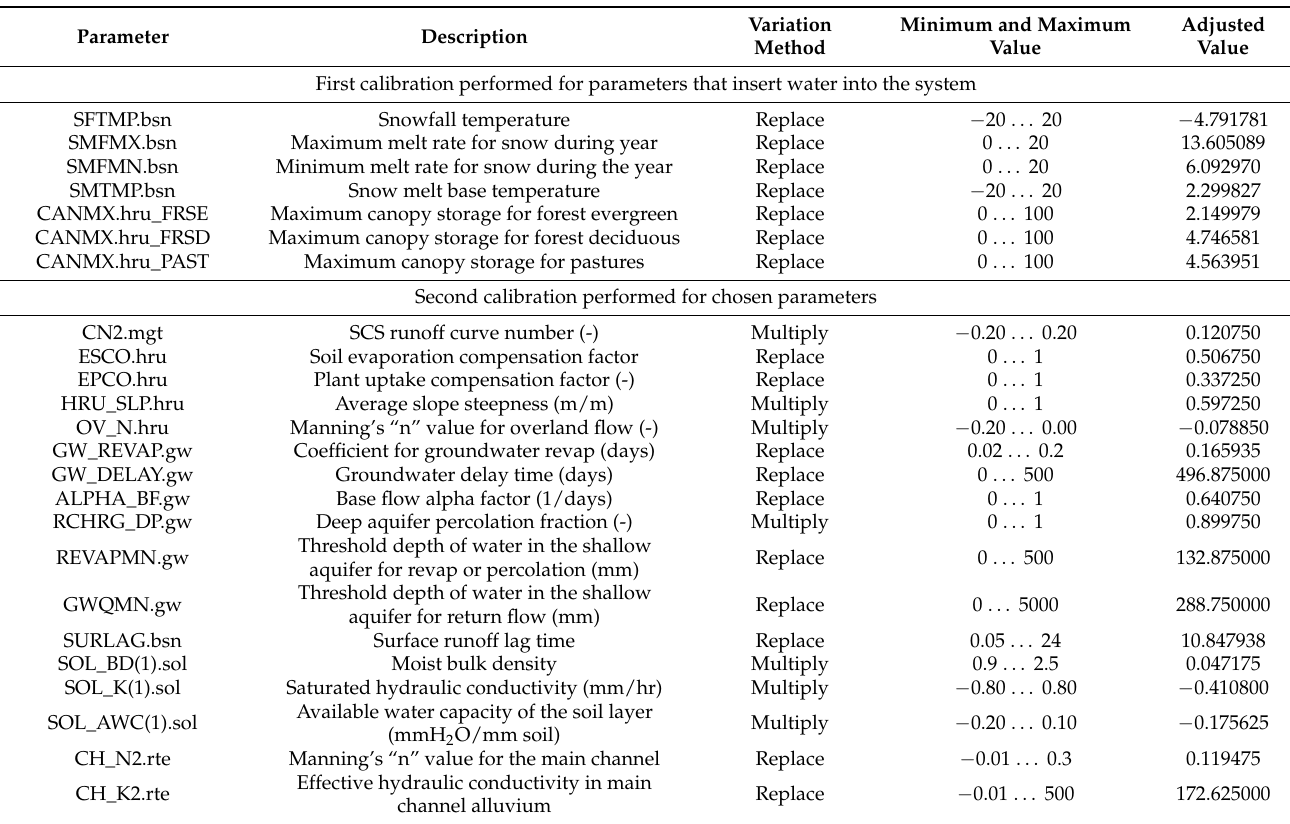
Table 1. The default range and adjusted values of parameters included in the calibration procedure.